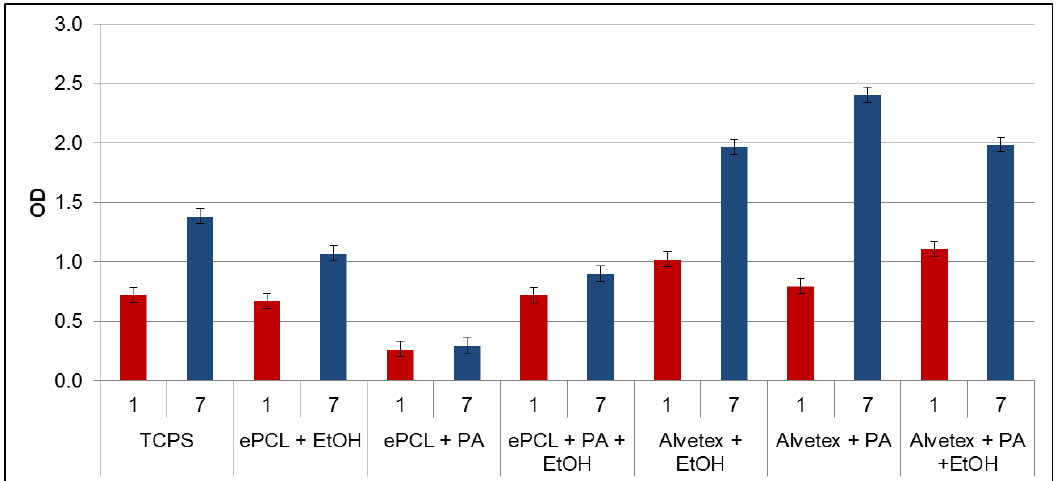
Figure 7. Cell proliferation data from MTS assay. Raw OD from 1-day and 7-day culture of MC3T3 osteoblasts across different substrates. All substrates show positive cell proliferation from day-1 to day-7 with the exception of ePCL treated with PA. There was no detectable signal at day-1 and day 7 indicating complete cytotoxicity of these scaffolds following PA exposure. Alvetex on the other hand showed increased cell proliferation after PA exposure. PA effects were effectively neutralized following ethanol wash.